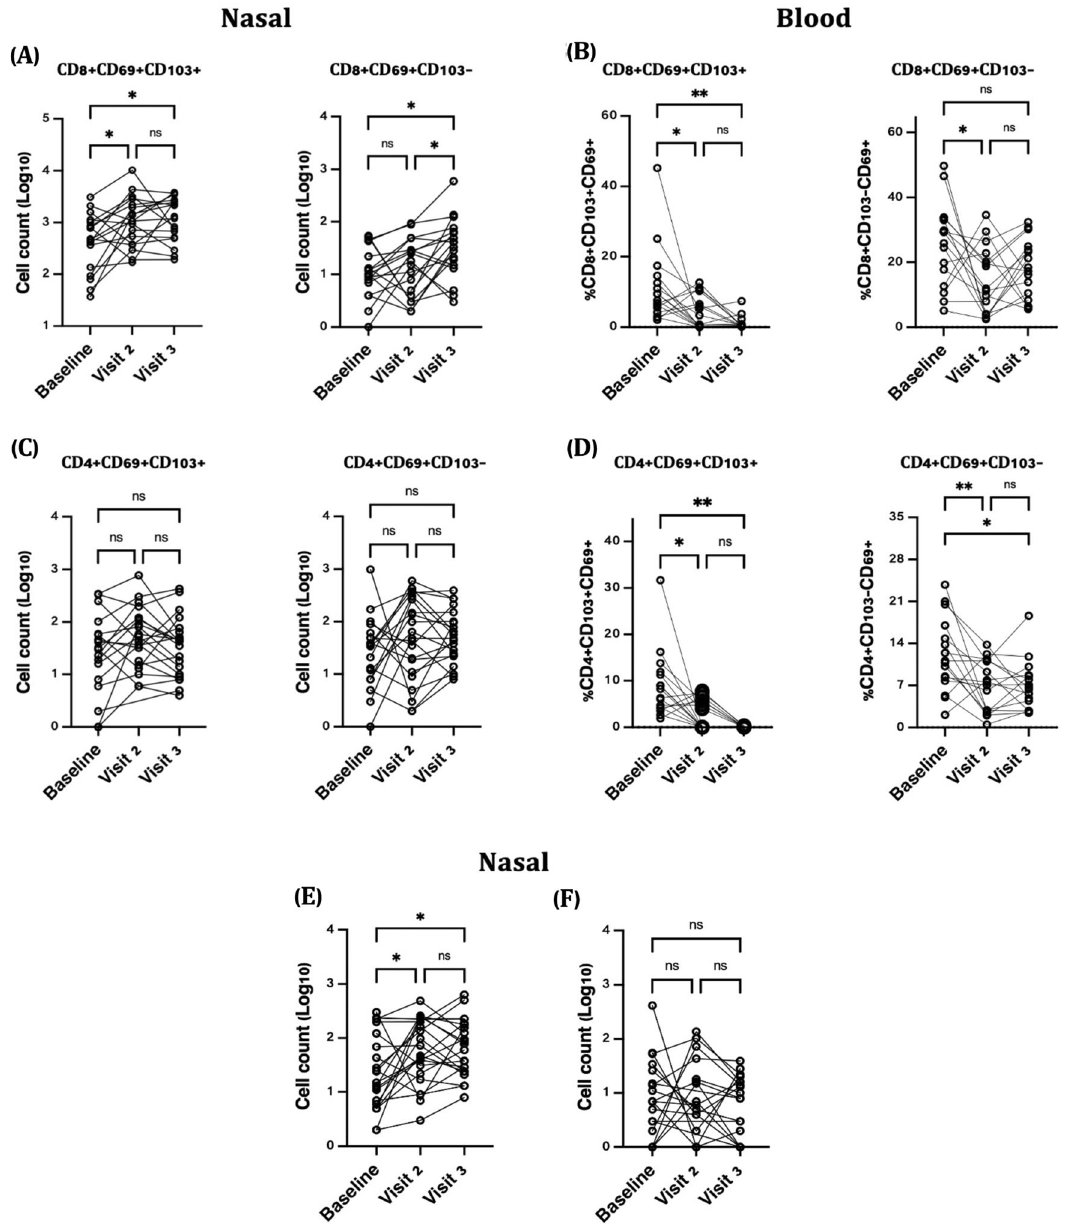
Fig. 2 Nasal cell counts per NP swab and peripheral blood frequencies of T cell subsets post SARS-CoV-2 vaccination ( n = 20). A Nasal CD8 + CD69 + CD103 + Trm signi fi cantly increased following the fi rst and second vaccine dose (* P > 0.01) while CD8 + CD69 + CD103 − T cells increased signi fi cantly following the second vaccine dose (** P > 0.001). B No changes in nasal CD4 + CD69 + CD103 + Trm (ns). C In blood , CD8 + CD69 + CD103 + Trm (** P > 0.001) and ( D ) CD4 + CD69 + CD103 + decreased signi fi cantly at visit 2 and 3 compared to baseline (** P > 0.001). E Signi fi cant increases in